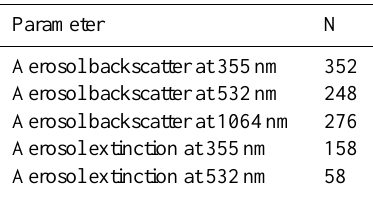
Table 1. Type and number (N) of optical properties profiles labeled as dust cases in the EARLINET database for the Potenza station. Aerosol backscatter at 1064nm and aerosol extinction at 532nm are available beginning in May 2006 after a major upgrade of the PEARL